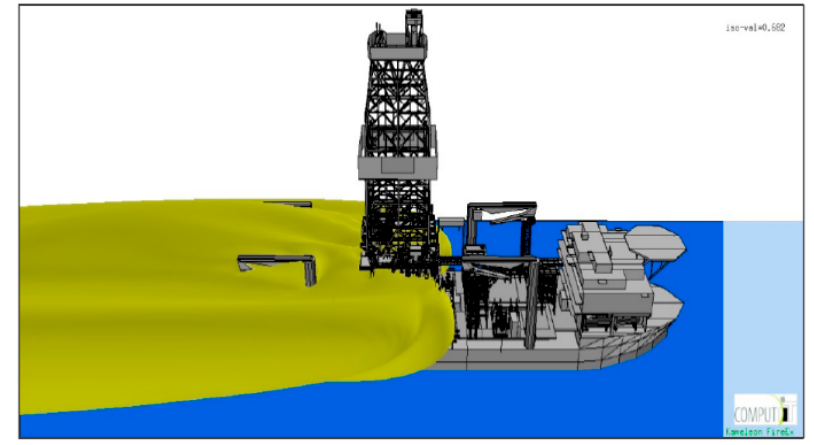
Figure 5. Iso-surface with 20% LFLlower flammable limit (=0.682%) when gas is released on the drill floor with full flowrate and 5.4 m/s wind blows from ( a ) the forward ( b ) and aft directions. Figure 6. Iso-surface with 20% LFL (=0.682%) when gas is released under the drill floor with full flow rate and 5.4 m/s wind blows from the forward direction.